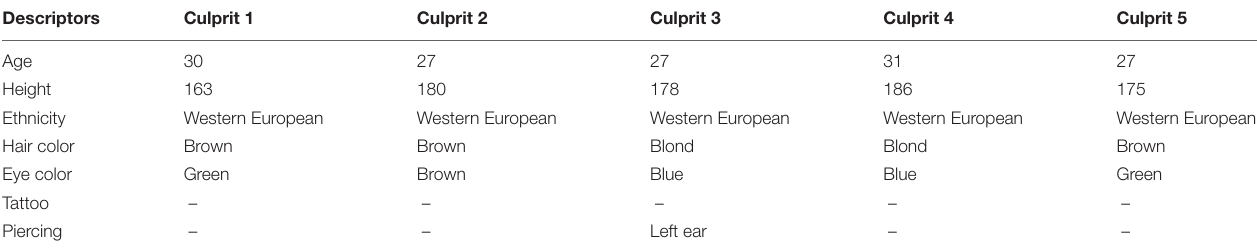
TABLE 1 | Description of culprits in Experiment